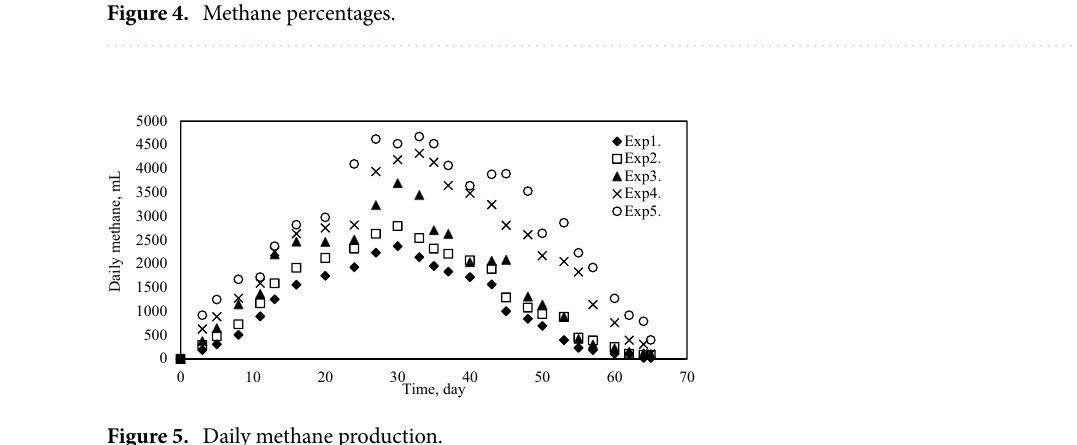
Figure 5. Daily methane production.